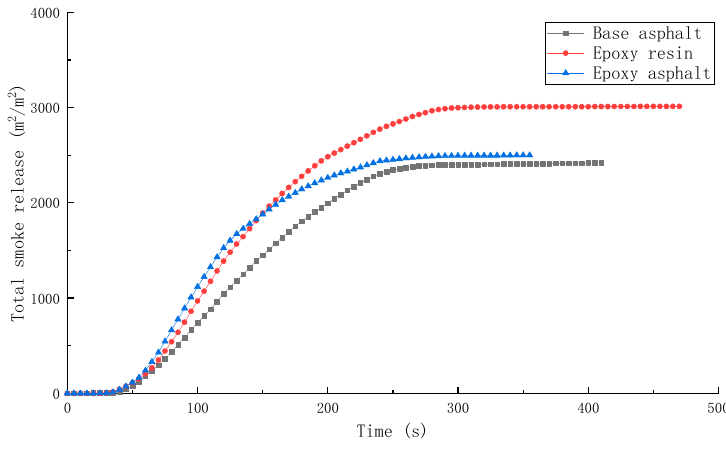
Figure 9. SPR of different materials.